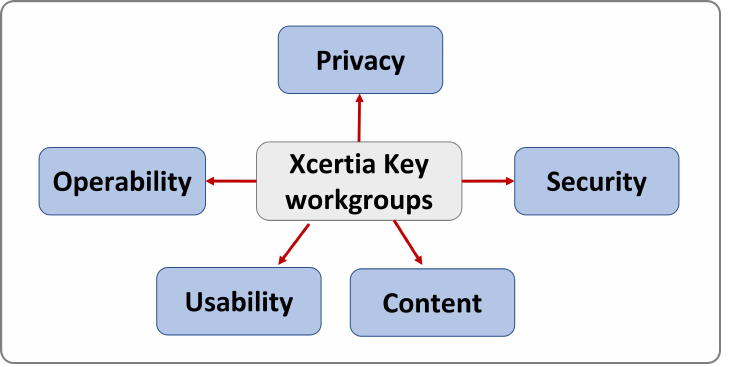
Figure 1. Xcertia